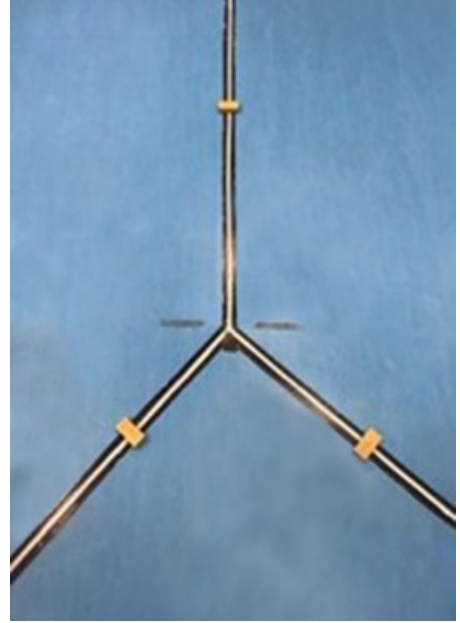
Figure 2. Modified-Upper Quarter Y-Balance Test (mUQYBT).